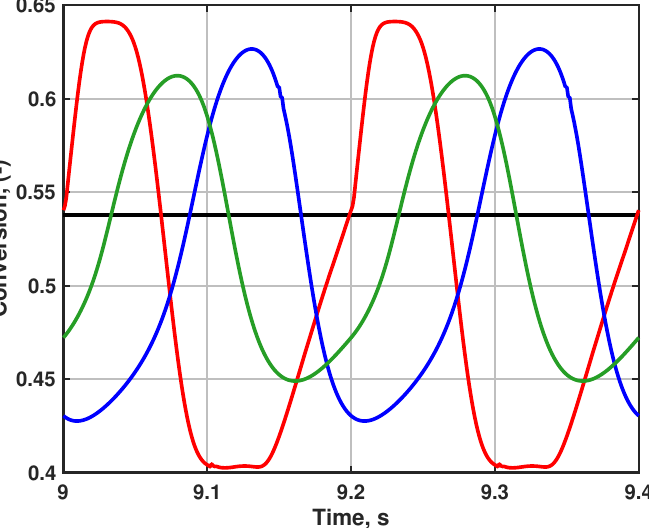
Figure 4. Conversion of reactant at system outlet over time as obtained in cases 1 (black), 2 (red), 3 (blue) and 4